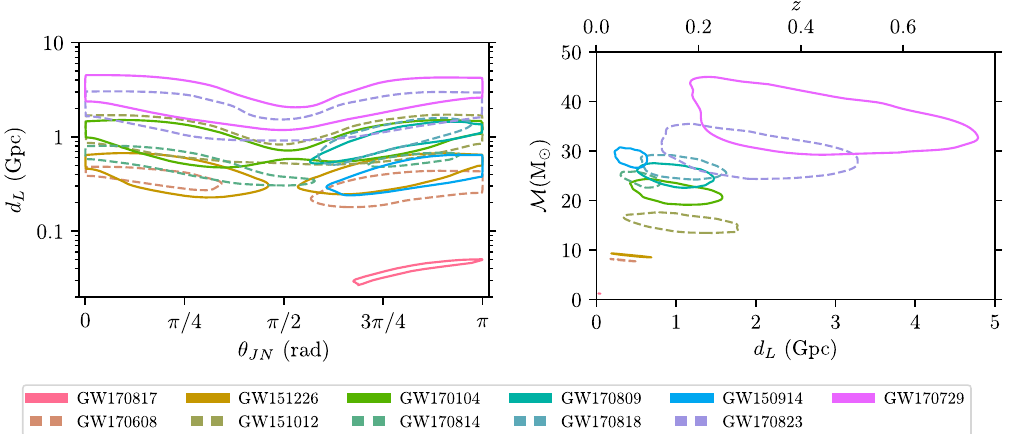
FIG. 7. Parameter estimation summary plots IV. Posterior probability densities of distance d L , inclination angle θ JN , and chirp mass M of the GW events. For the two-dimensional distributions, the contours show 90% credible regions. For GW170817, we show results for the high-spin prior a i < 0 . 89 . Left: The inclination angle and luminosity distance of the binaries. Right: The luminosity distance (or redshift z ) and source-frame chirp mass. The colored event labels are ordered by source-frame chirp mass.